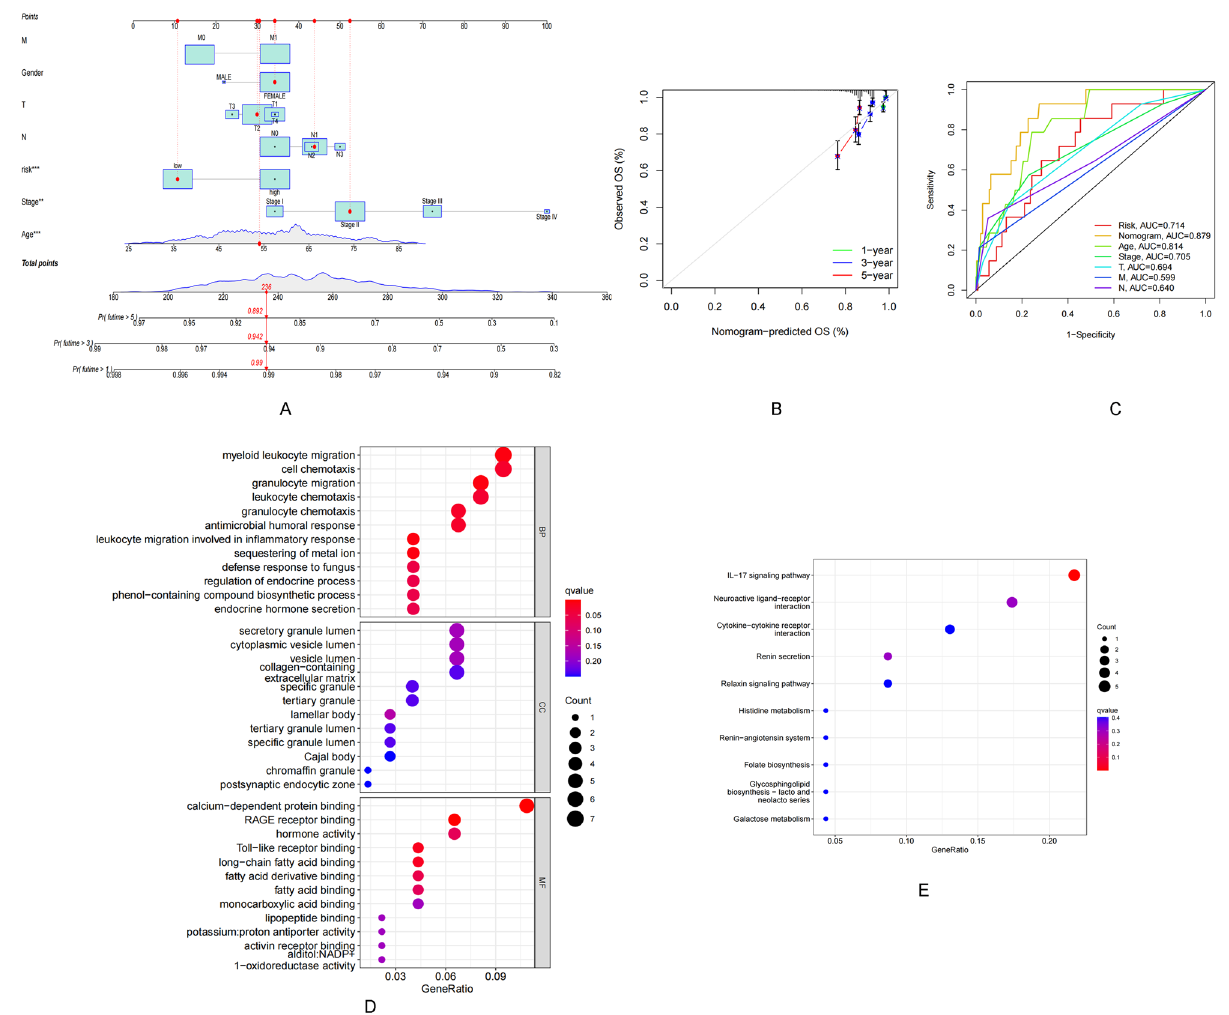
Figure 5. Nomogram and assessment of the risk model. ( A ) Nomogram predicting the probability of 1-year, 3-year, and 5-year OS for risk score and clinical characteristics. ( B ) Calibration curves of the nomogram for predicting of 1-, 3-, and 5-year OS in all BRCA patients. ( C ) ROC curves for risk score, Nomogram score, and clinical characteristics. ( D , E ) GO and KEGG enrichment analysis of risk score-associated